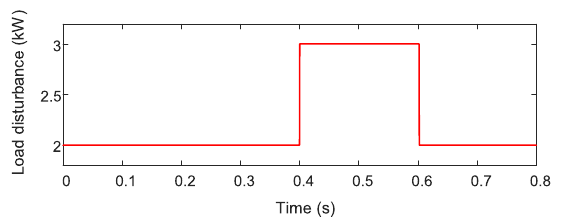
Fig. 12 Sudden change in the